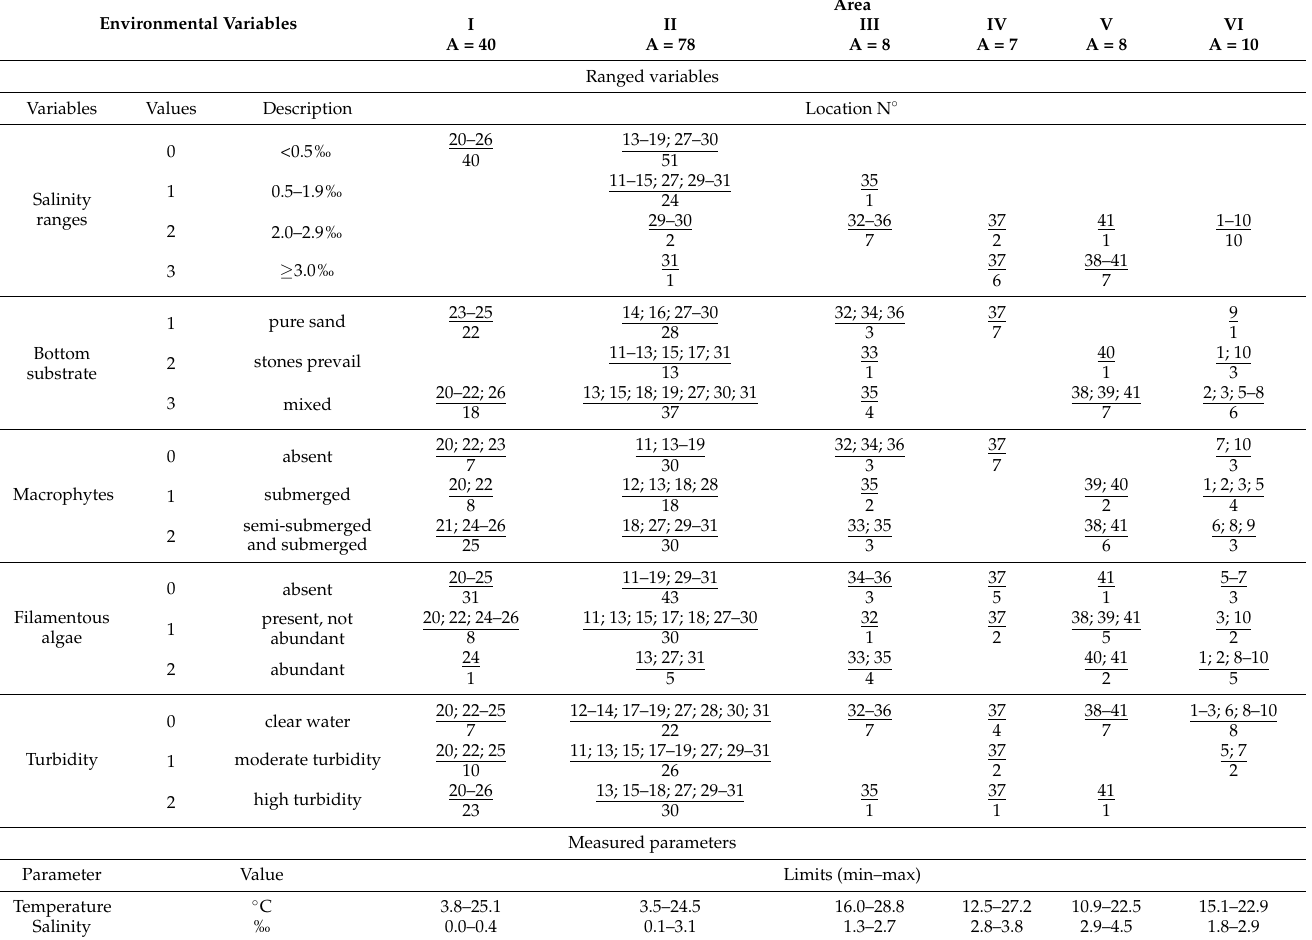
Table A1. Environmental variables at the coastal locations surveyed in